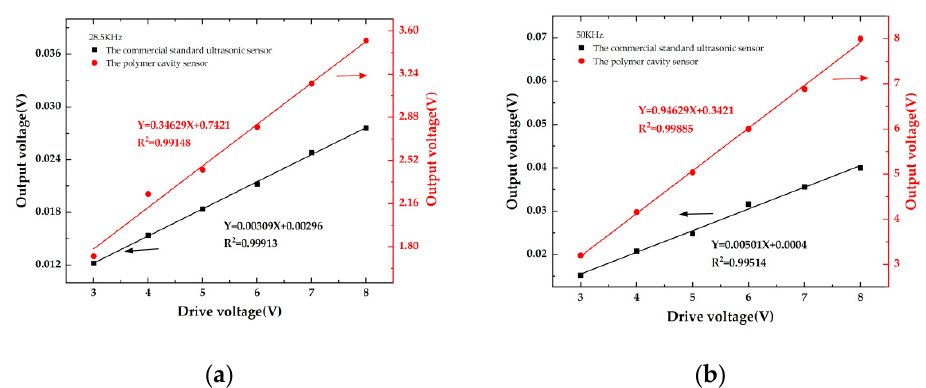
Figure 5. Relationship between the maximum PP voltage and diver voltage of the polymer cavity